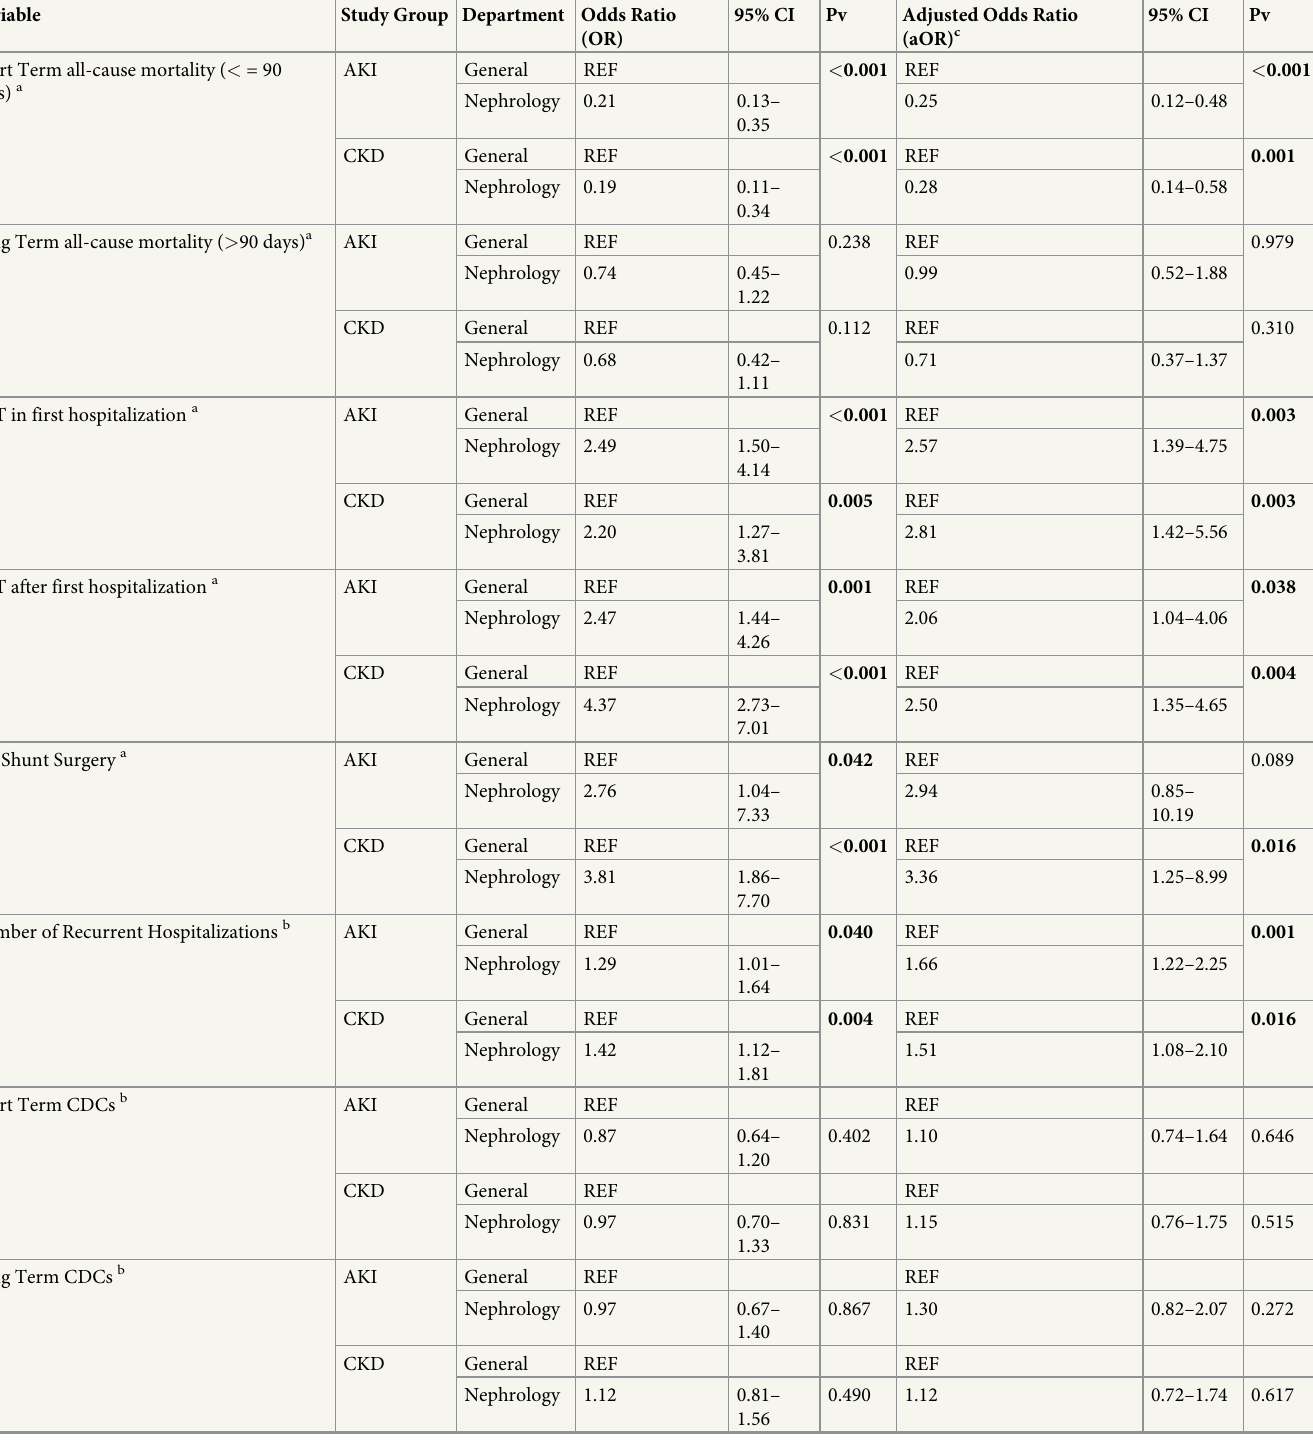
Table 3. Association between department type and clinical outcomes univariate analysis multivariate